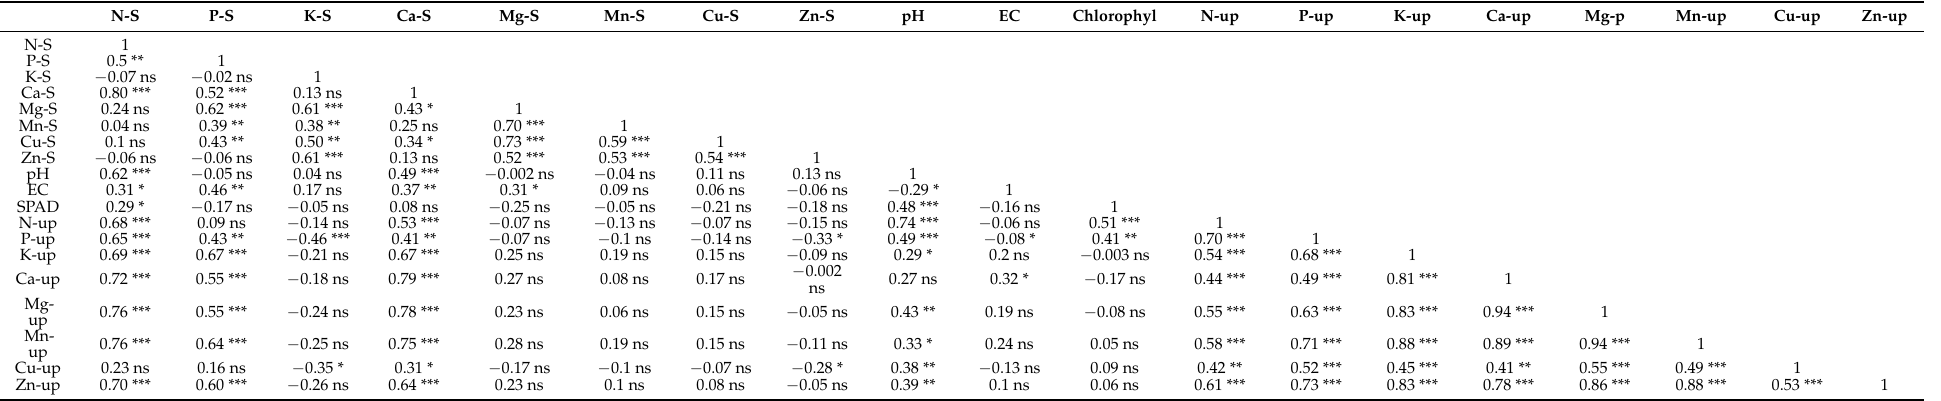
Table 9. Pearson correlation coefficient (r) between the means of selected soil physicochemical, plant growth and nutrient uptake in greenhouse studies conducted on 12 treatments on Oxisols